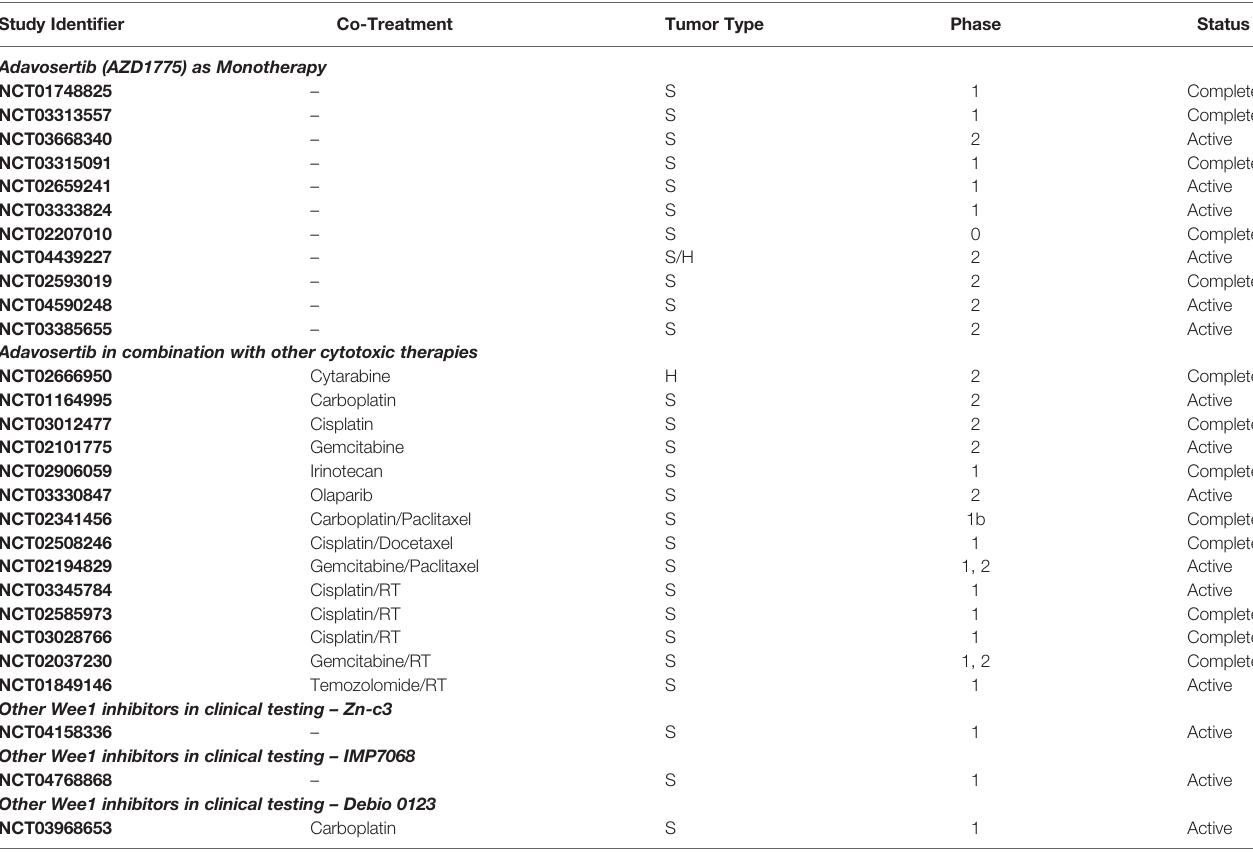
TABLE 1 | Wee1 inhibitors in clinical